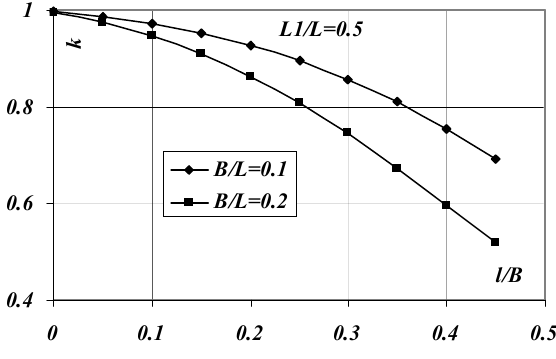
Fig 3. The coefficient crack influence to the critical force of compressed rod with rectangle